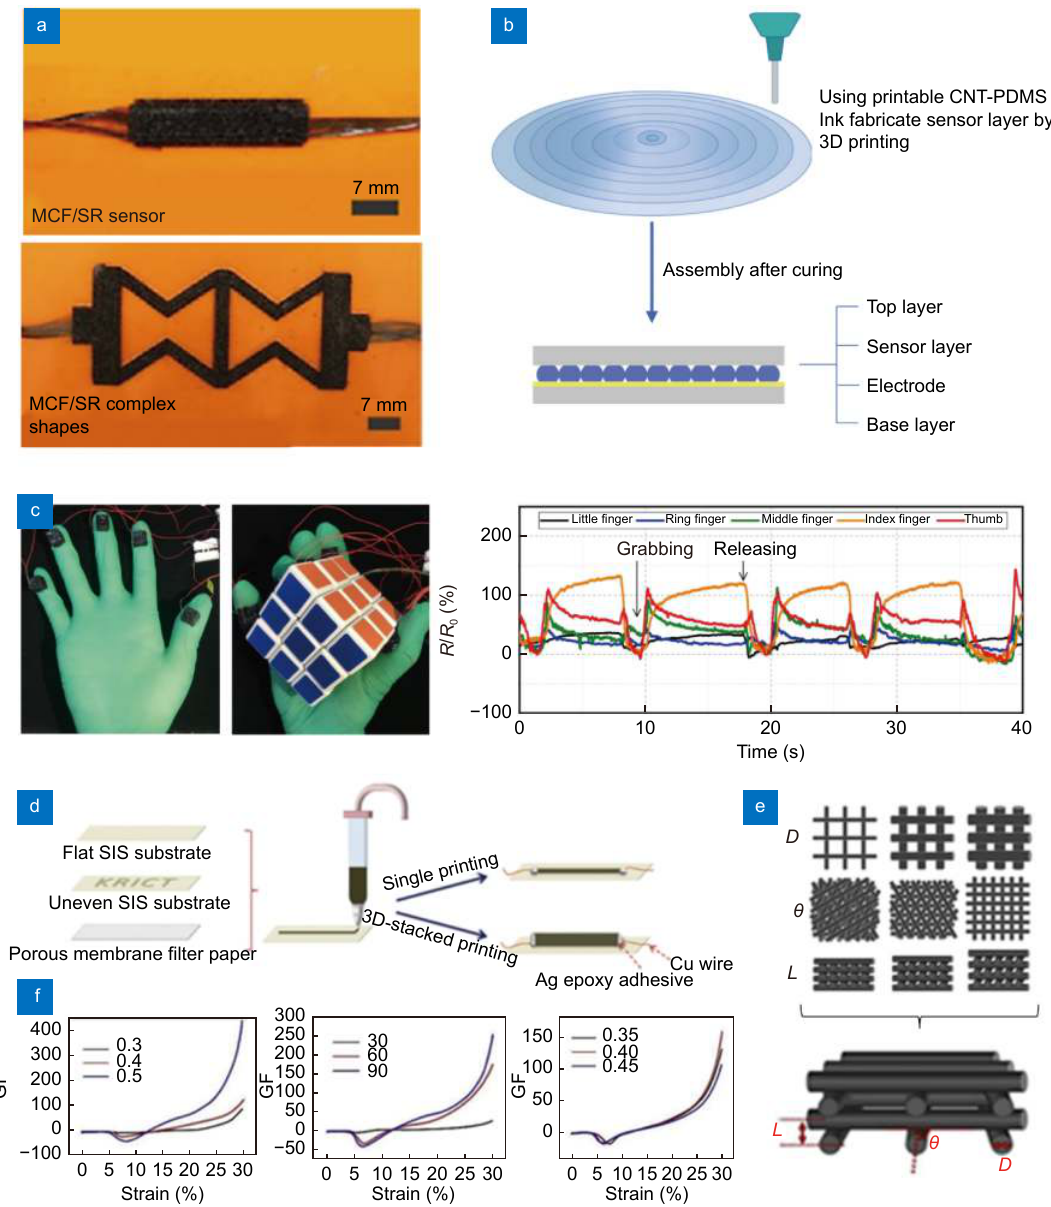
Fig. 9 | Additive manufacturing for piezoresistive sensor. ( a ) Drop-on-demand material jetting for the facial fabrication of piezoresistive struc- tures 143 . MCF, milled carbon fibers; and SR, silicone rubber. ( b ) 3D printing of human-skin-inspired texture as piezoresistive sensing layers 144 . CNT, carbon nanotube. ( c ) Application of a 3D printed piezoresistive sensor for robotic fingertips to sense force 145 . ( d ) 3D printing of conducting composite for piezoresistive sensor 148 . SIS, polystyrene–polyisoprene–polystyrene. ( e , f ) 3D printing of different structure parameters (e.g. dia- meter, interaxial angle, and interlayer space) for piezoresistive sensor 149 . GF, gauge factor. Figure reproduced with permission from: (a) ref. 143 , (e, f) ref. 149 , Elsevier; (c) ref. 145 , American Chemical Society; (d) ref. 148 , Royal Society of (Fig. 9(e) and 9(f)). The parameters of fibre diameter, in- stan and obtained an asymmetric sensing structure cap- terfibre angle, and layer height impacted the sensor’s GF able of detecting the angle and direction of blending. significantly, and even after experiencing 50% of com- pressive strain, the sensor could recover quickly with little deformation. Using AM-assisted fabrication, Zhou et al. 150 developed a highly flexible and resistive piezores- istive strain sensor from the commercial resin and Galin-